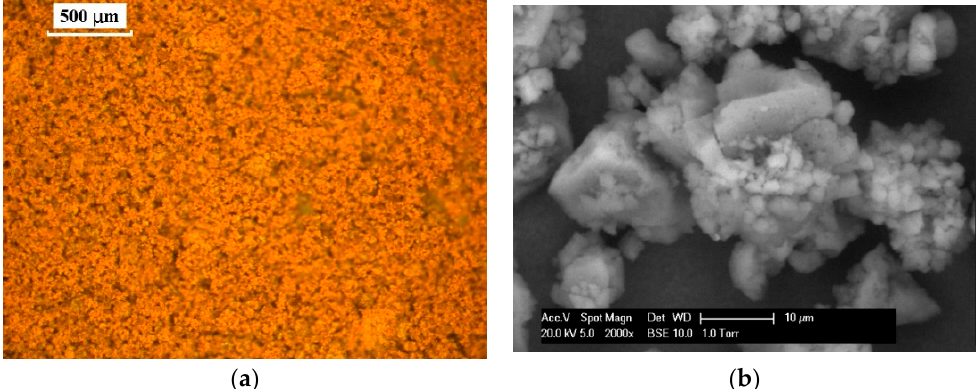
Figure 1. Microscope images of organosolv lignin powder; ( a ) optical microscope and ( b ) environmental scanning electron microscope (ESEM) image of lignin powder.